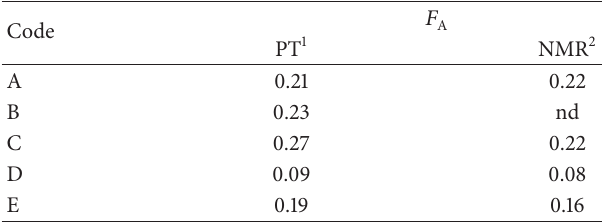
Table 5: Degree of acetylation of chitosan samples determined by potentiometric titration and 1 H